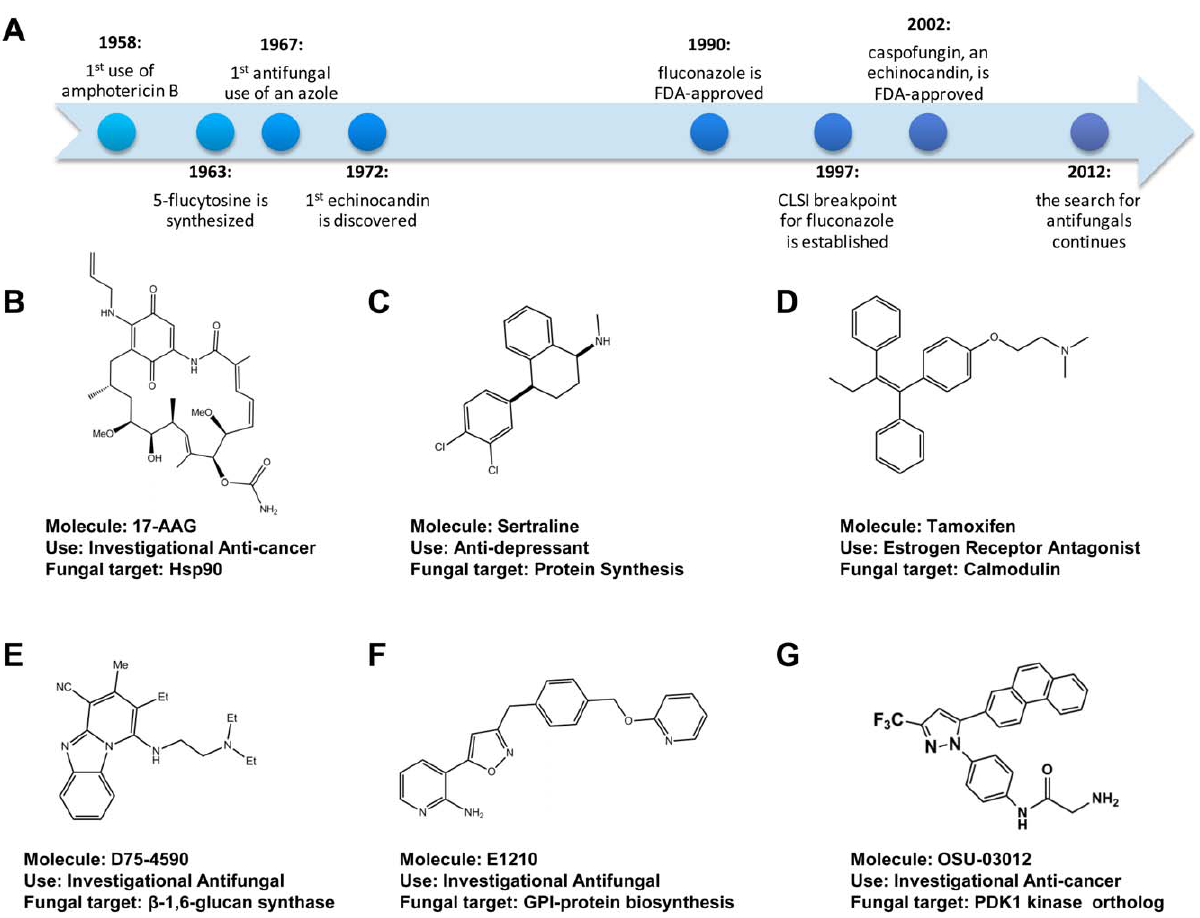
Figure 1. Antifungal drug development timeline. (A) Timeline of selected milestones in antifungal drug development. (B–G) Chemical structure, name, clinical use, and putative molecular target of antifungal drugs and small molecules discussed in the text.